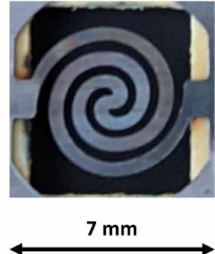
Figure 4. Representation of the bare Pre-HG, before the deposition of the sensing